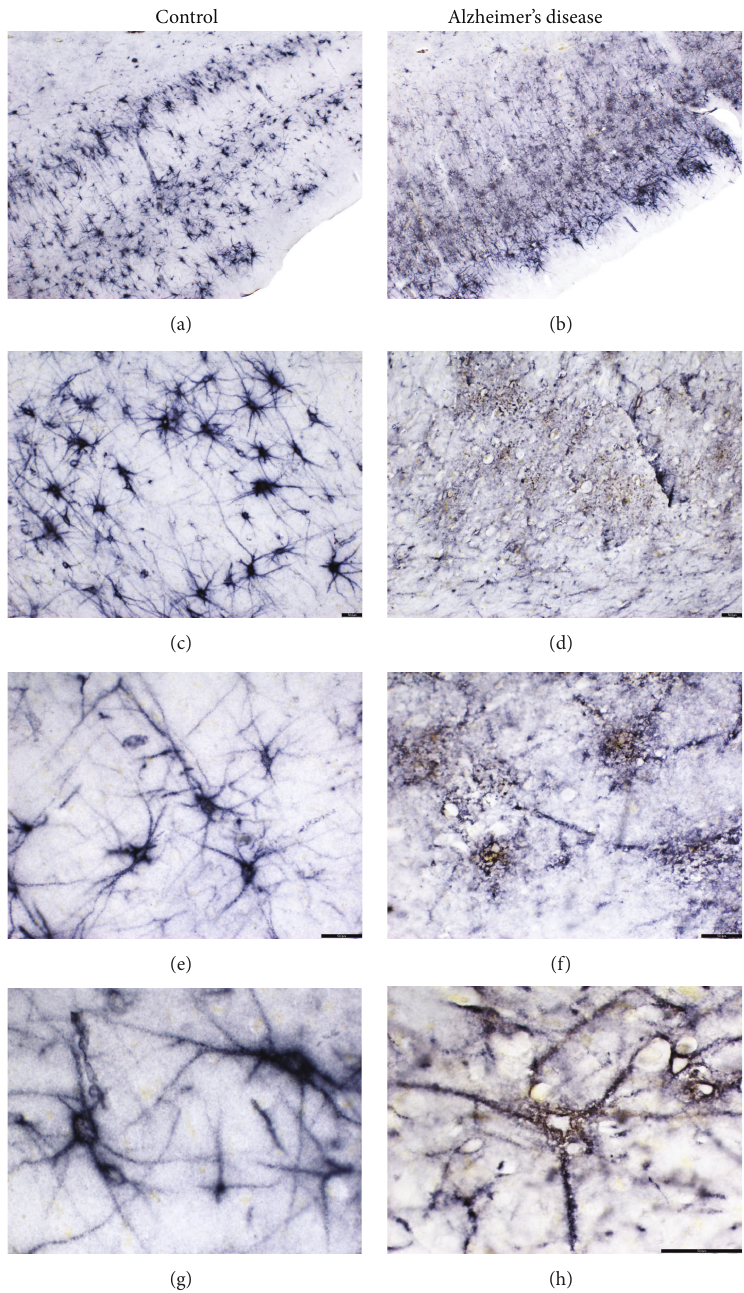
Figure 4: PNN structure is altered in Alzheimer’s disease. Examples of WFA-labeled PNNs in the entorhinal cortex of healthy subjects (a, c, e, g) and subjects with Alzheimer’s disorder (b, d, f, h). In healthy subjects, WFA-labeled PNNs are distributed across all layers of the ECx, with preferential concentration in layers II-III and layers V-VI (a). In subjects with Alzheimer’s disease, WFA labeling appears to be more loosely distributed, in aggregates throughout the ECx, often suggestive of degraded PNNs (b, d, f,